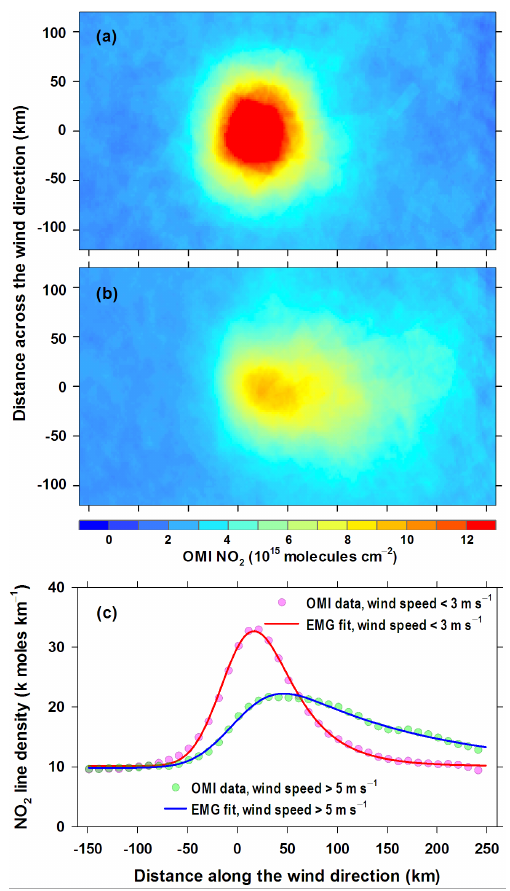
Figure 2. Wind-aligned OMI NO 2 TVCD maps at wind speeds (a) <3ms − 1 and (b) >5ms − 1 for Chicago in summer months (i.e., April–September) during 2005–2007. (c) OMI NO 2 line densities of (a) and (b) and the corresponding EMG fits. Line densities are from the integration of the NO 2 data in the across-wind